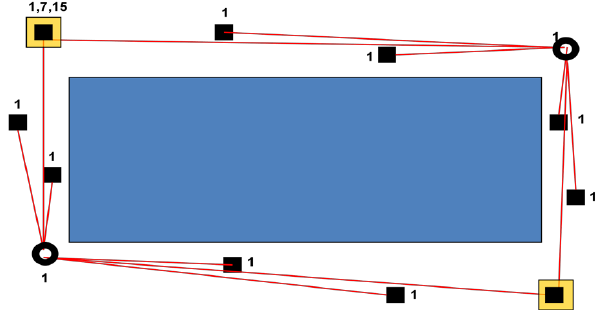
Fig. 2. Configuration of Indiana experiment. The scanning TDLAS (open circle), retro-reflectors (filled squares), towers (yellow squares) and open paths (solid lines) are shown with the height of the equipment indicated in meters.